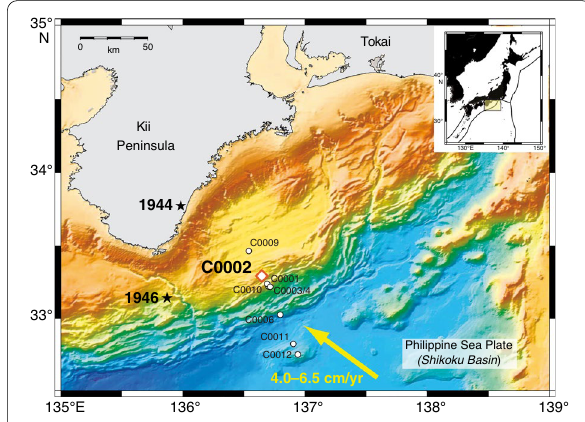
Fig. 1 Map of the NanTroSEIZE drilling sites. Site C0002 is indicated by the red square, and white circles mark the other NanTroSEIZE sites (after Tobin et al. 2015). Yellow arrows denote the estimated far-field vectors between the Philippine Sea Plate and Japan (Heki and Miyazaki 2001). Stars mark the hypocenters of the 1944 and 1946 great